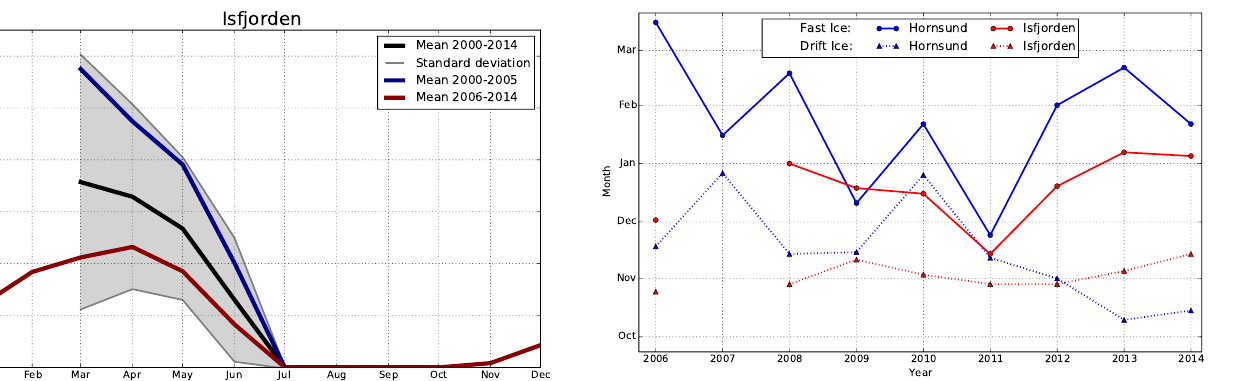
Figure 5. Monthly averaged fast ice coverage in Isfjorden shown for three time periods: 2000–2014 (mean in black and standard de- viation in grey) 2000–2005 (blue) and 2006–2014 (red).